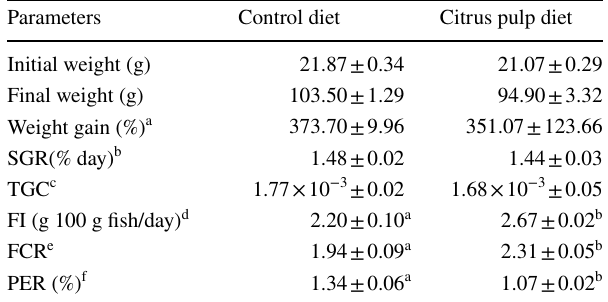
Values are ± SD of three replications. Data in the same row with dif- ferent superscripts differ at ( P < 0.05). Initial weight in each phase was considered as co variable for final weight and SGR